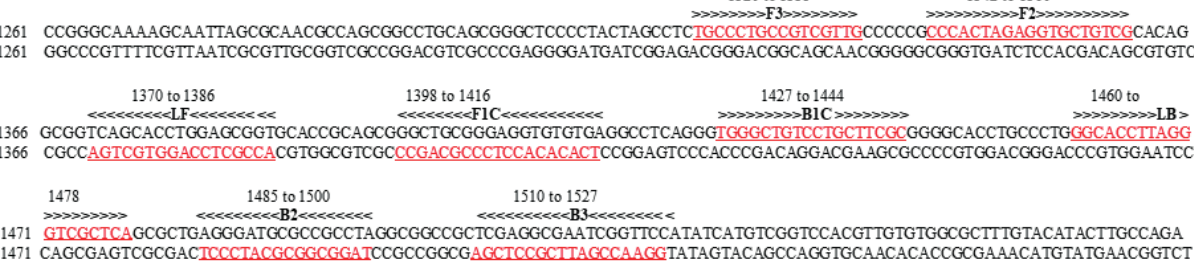
Figure 1. Positioning and orientation of LAMP primers within the nucleotide sequence of the IGS region of Pleurostoma